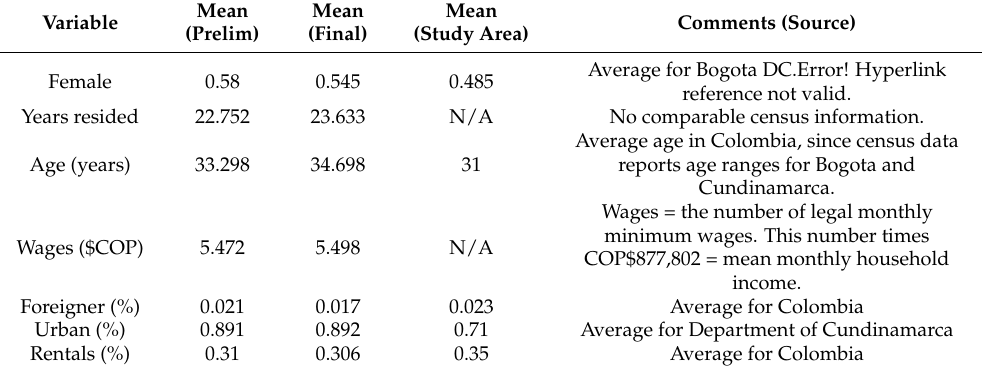
Table 2. Sociodemographic characteristics for the survey respondents ( n = 2359) in both the Prelim and Final data sets. Study area socio-demographics are also presented. Note: since some of the variables were designed based on the study’s research objectives, many do not have an equivalent in a National- or Regional-level census. Additionally, some means were only available at the Bogot á DC, Department of Cundinamarca, or National level, as indicated in Comments. Links to the sources used to report the study area means are found in websites reported in Appendix